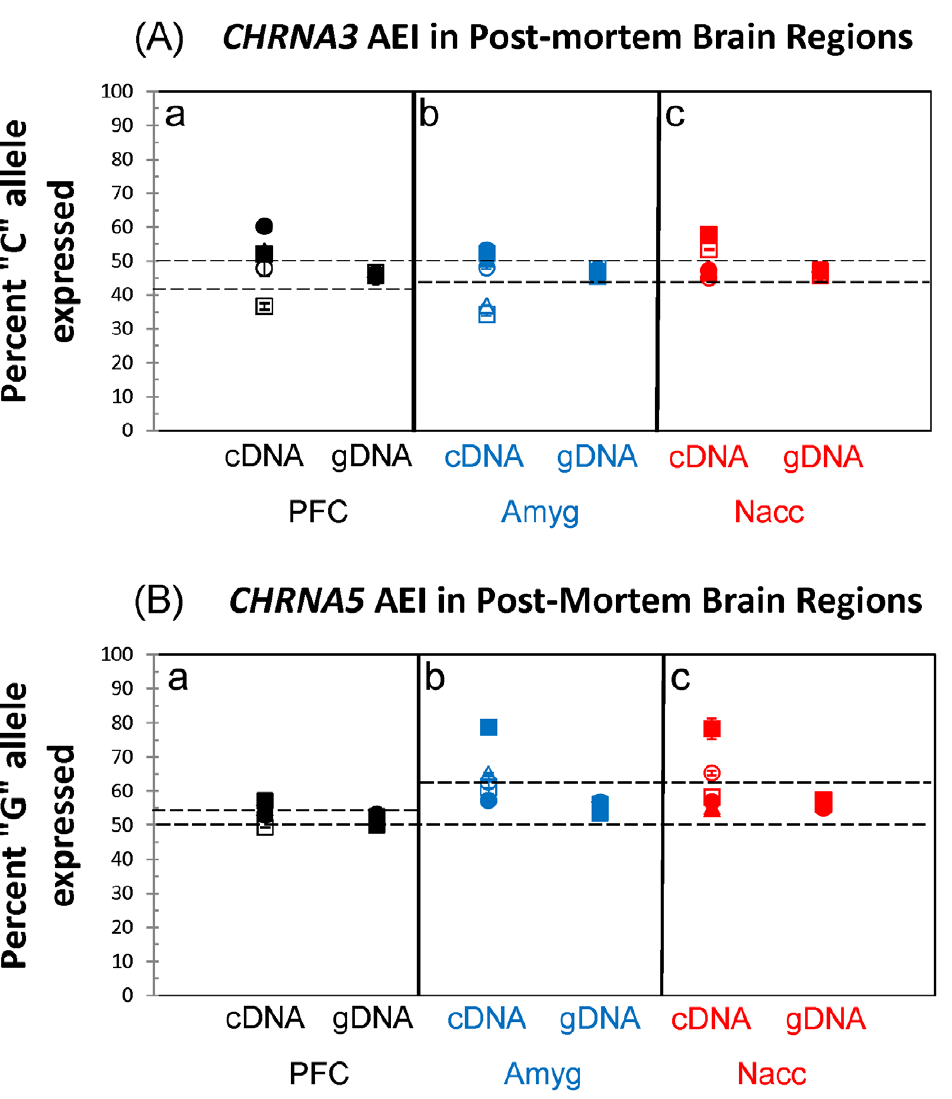
Figure 5. Allelic expression imbalance (AEI) of CHRNA3 and CHRNA5 in post-mortem brain regions. The SNaPshot system was used to assess the relative allelic expression of either CHRNA3 (A) or CHRNA5 (B) in complementary DNA (cDNA) preparations derived from mRNA of post- mortem brain regions, including the prefrontal cortex (PFC, black symbols), amygdala (Amyg, blue symbols) or nucleus accumbens (Nacc, red symbols). Genomic DNA (gDNA) from each individual was used as a control for no imbalance ( i.e. 50% from either allele). The averages 6 standard deviations of at least two determinations for each point are shown. (A) The percent rs1051730-[C] (%C) allelic expression from CHRNA3 is shown for all heterozygous individuals tested in the PFC (black symbols; individuals 1 through 6 are represented as closed squares, open squares, closed triangles, open triangles, closed circles or open circles, respectively), the Amyg (blue symbols; individuals 7 through 12 are represented as closed squares, open squares, closed triangles, open triangles, closed circles or open circles, respectively) or the Nacc (red symbols; individuals 7 through 12 are represented as closed squares, open squares, closed triangles, open triangles, closed circles or open circles, respectively). Dashed lines represent the degree of error in our standard curve method as determined by the formula ((expected %C in gDNA-observed %C in gDNA)/expected %C in gDNA). This corresponds to 8% in the PFC determinations (panel ‘‘a’’) and 7% error in the Amyg (panel ‘‘b’’) and Nacc (panel ‘‘c’’) determinations. (B) The percent rs16969968-[G] (%G) allelic expression from CHRNA5 is shown for all heterozygous individuals tested in the PFC (black symbols; individuals 1 through 6 are represented as closed squares, open squares, closed triangles, open triangles, closed circles or open circles, respectively), the Amyg (blue symbols; individuals 7, 8, and 10 through 12 are represented as closed squares, open squares, and open triangles, closed circles or open circles, respectively) or the Nacc (red symbols; individuals 7 through 12 are represented as closed squares, open squares, closed triangles, open triangles, closed circles or open circles, respectively). Dashed lines represent the degree of error in our standard curve method as determined by the formula ((expected %G in gDNA-observed %G in gDNA)/expected %G in gDNA). This corresponds to 3% in the PFC determinations (panel ‘‘a’’) and 11% error in the Amyg (panel ‘‘b’’) and Nacc (panel ‘‘c’’) determinations. Note individual ‘‘7’’ (closed square) showing 80% rs16966968-[G] expression in both the Amyg (blue square, panel ‘‘b’’) and Nacc (red square, panel ‘‘c’’). doi:10.1371/journal.pone.0023373.g005 our data in BE(2)-C cells agree with most of these in vitro studies, The rs3841324 deletion encompasses a few transcription factor indicating decreased relative CHRNA5 promoter activity from the binding sites, including SP-1 [2,25], a transcription factor which promoter with a deletion at rs3841324, the e x vivo studies suggest activates transcription. The large shift of the probe with HeLa the opposite effect [26,27]. nuclear extract might indicate binding of factors other than SP-1